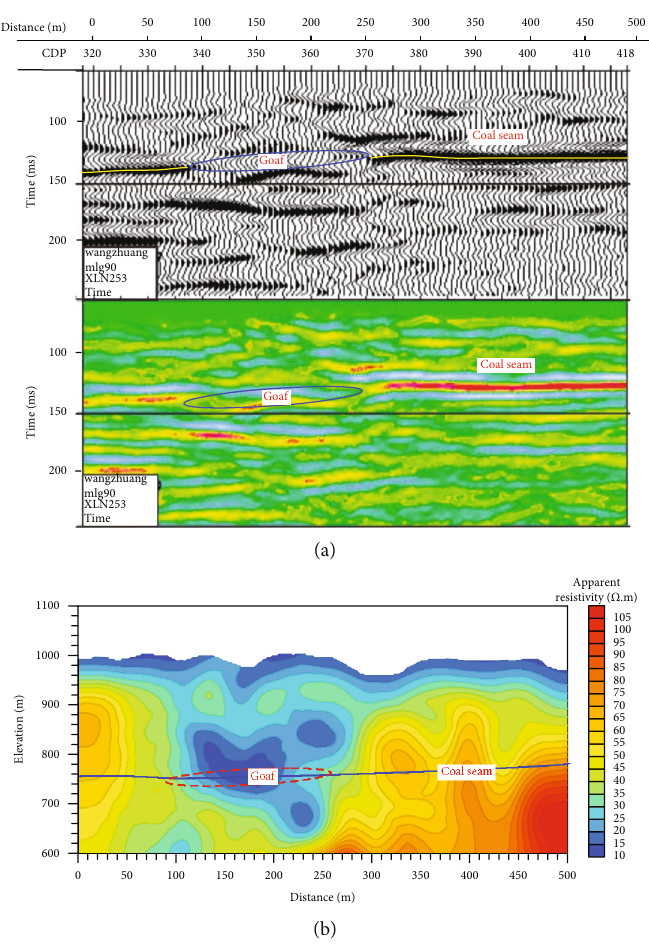
Figure 4: Goaf in a time pro fi le (a) and in a transient electromagnetic pro fi le